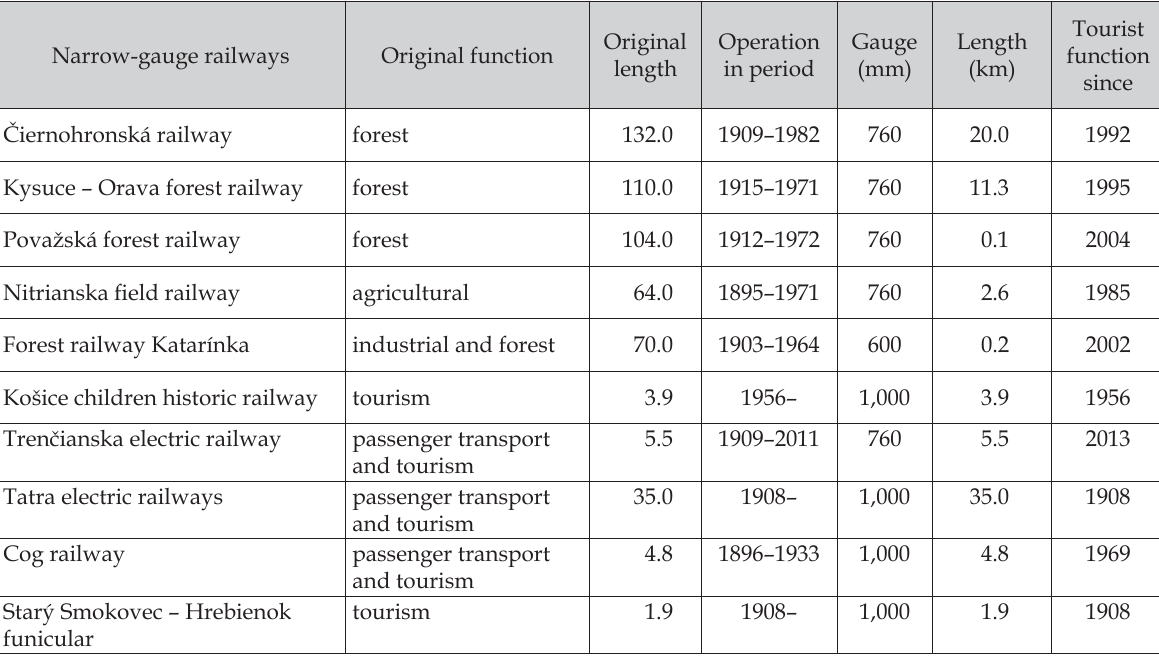
Table 2. Narrow-gauge railways in